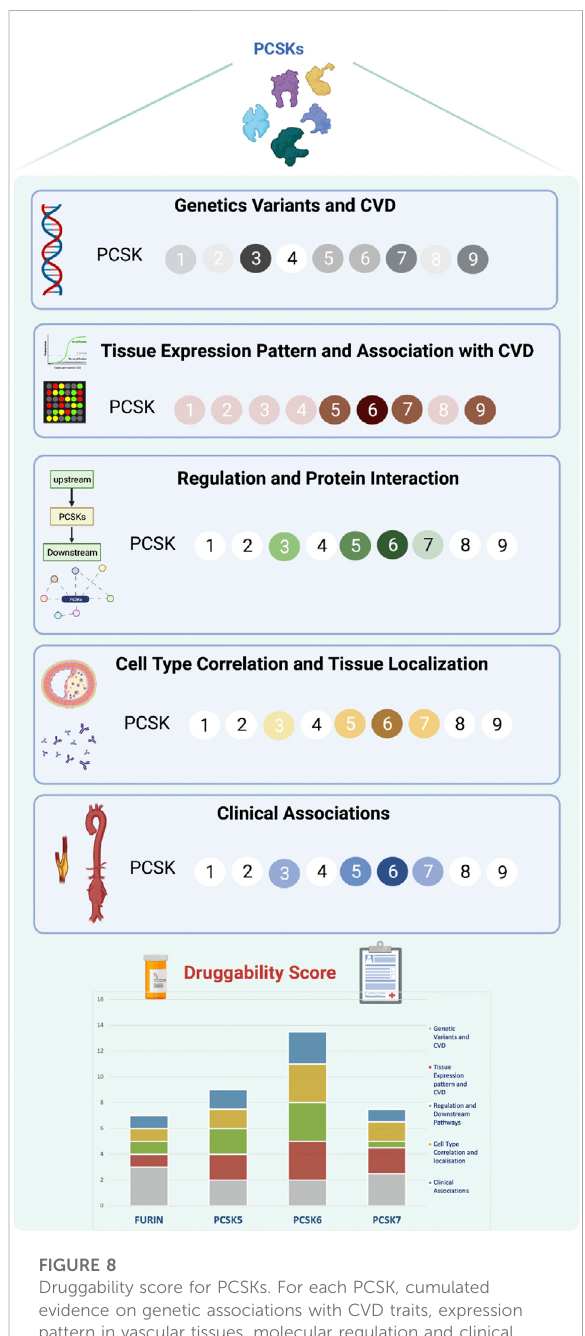
FIGURE 8 Druggability score for PCSKs. For each PCSK, cumulated evidence on genetic associations with CVD traits, expression pattern in vascular tissues, molecular regulation and clinical associations were integrated in a druggability score assessing their therapeutic targeting potential for CVD. Darker colours in each section refer to a higher score and lighter colours indicate lower score. Scoring details may be found in Supplementary